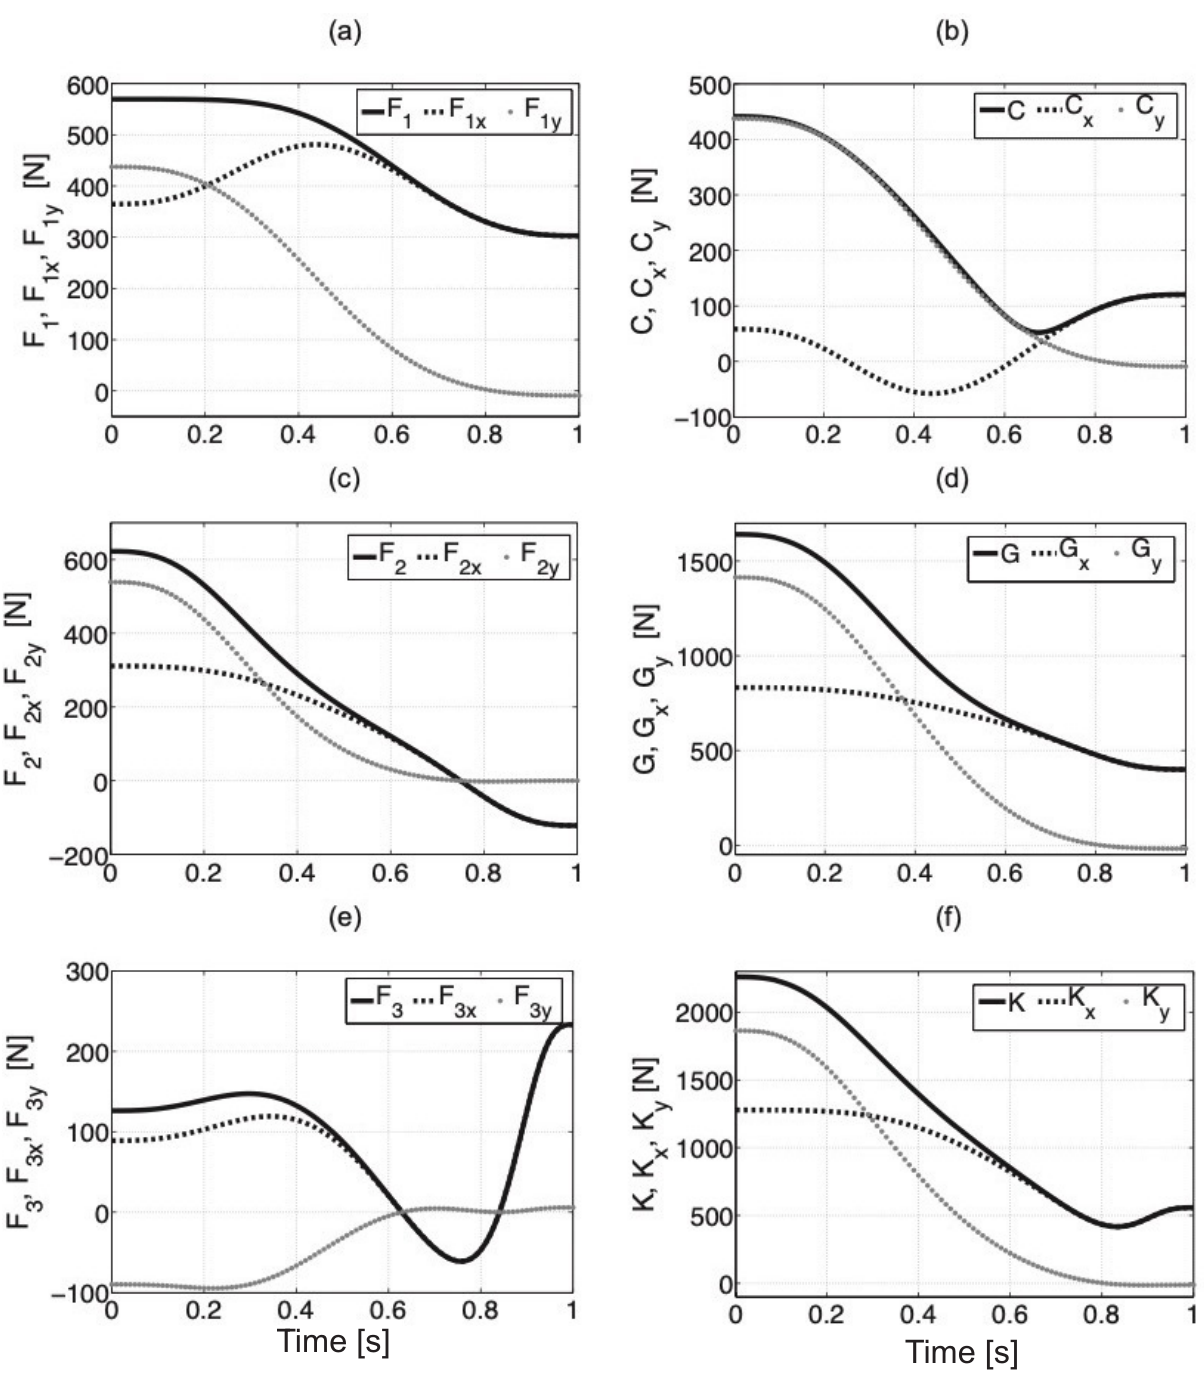
Figure 7. Force values F 1 ( a ), F 2 ( c ), and F 3 ( e ) with components x and y, reactions with components x and y for hip joint ( b ), knee joint ( d ), and ankle joint ( f